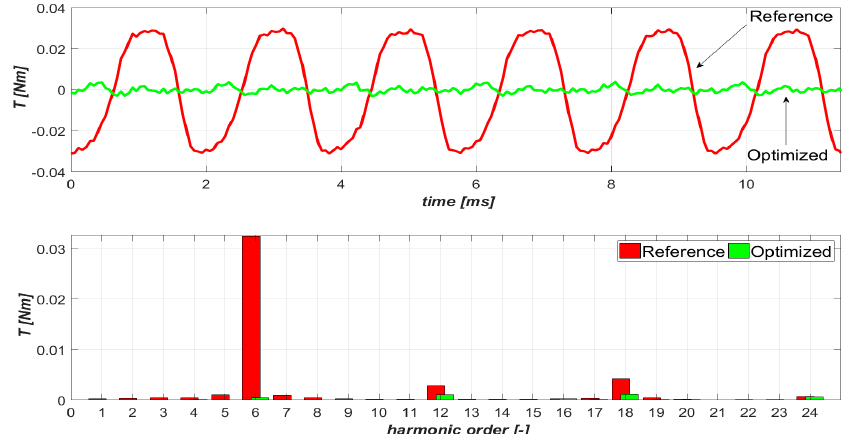
Figure 5. Torque ripple waveforms and their harmonic content (base structure of n s / n p equal to 9 / 10).